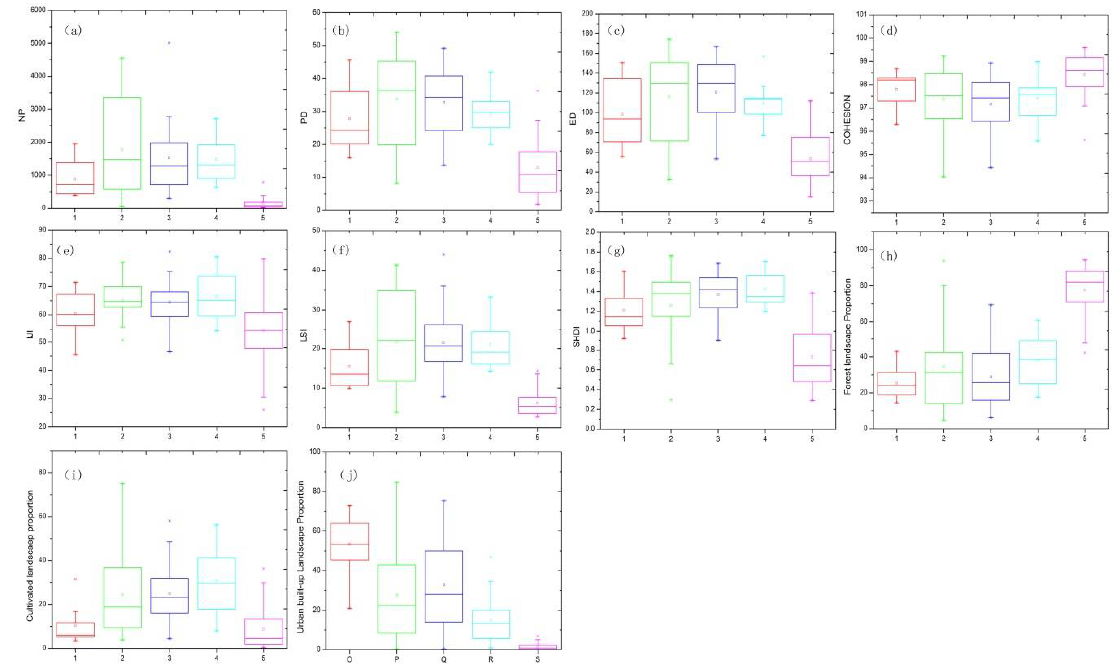
Figure 4. Boxplots of landscape metrics representing the composition and spatial configuration in different spatial clusters from 1990 to 2010, ( a ) NP; ( b ) PD; ( c ) ED; ( d ) Cohesion; ( e ) IJI; ( f ) LSI; ( g ) SHDI; ( h ) ForestP; ( i ) CultiP; ( j ) UrbanP .